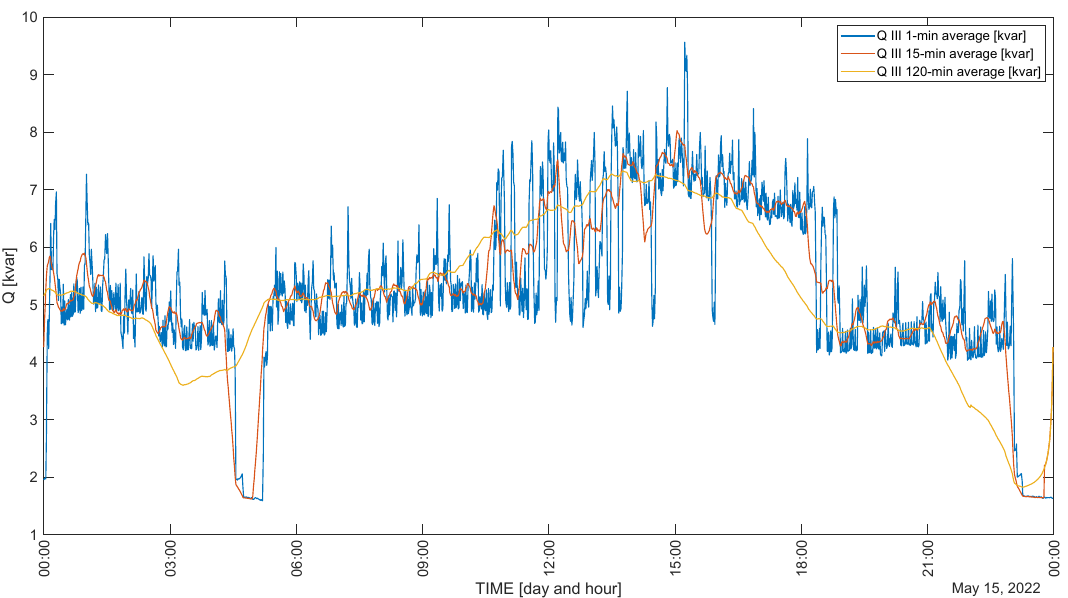
Figure 13. Three-phase reactive power as a function of time on a representative day of the 2nd stage.